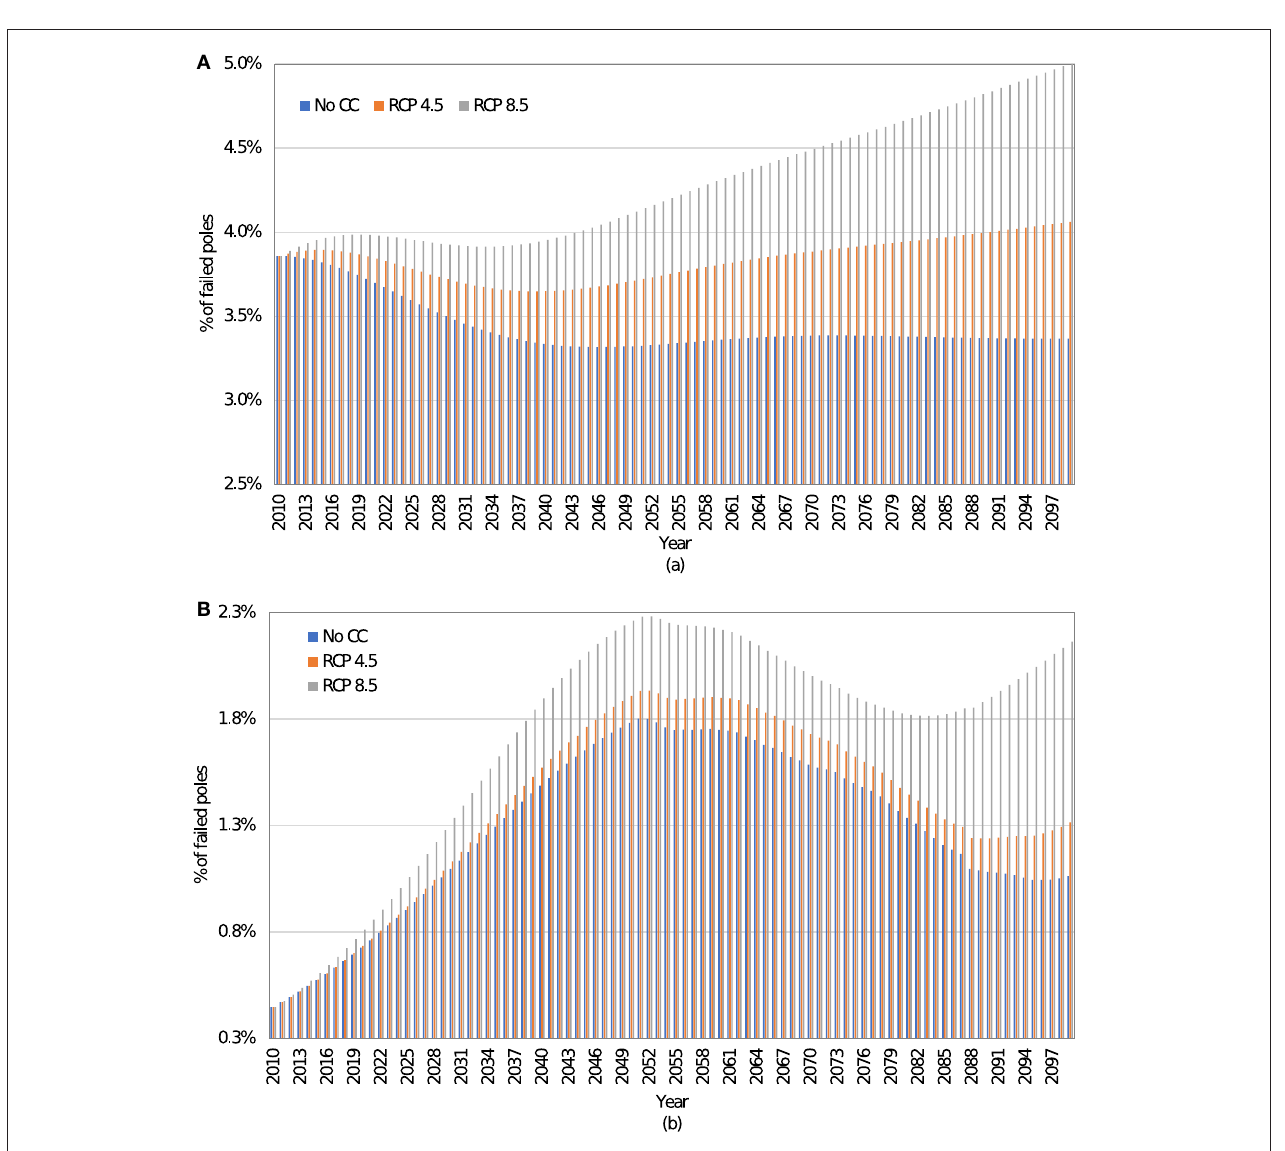
FIGURE 6 | Percentage of failed poles in (2010–2099) (A) Miami (B) NYC.